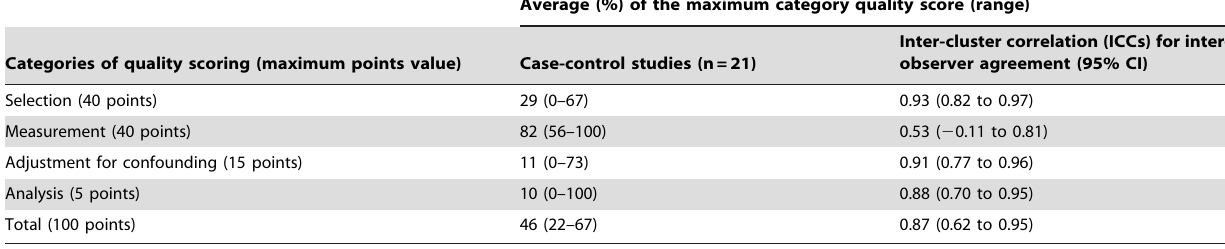
Table 2. Average quality scores and inter-observer agreement on scoring for all studies included in the